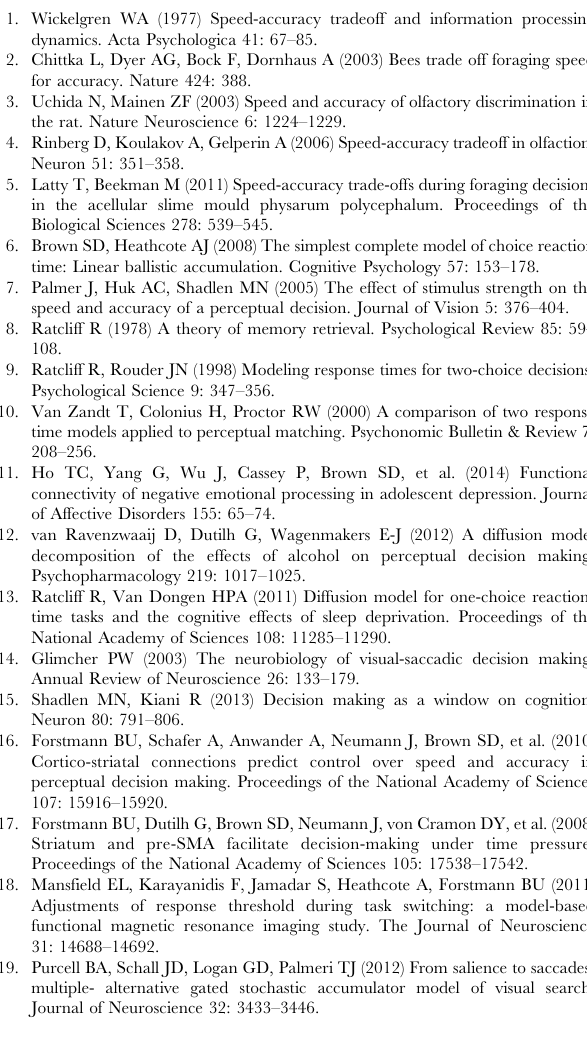
Figure S5 Fine grain structure of response time distributions displyed in Figure 1. Lines overlaid on the accuracy RT distributions represent Gaussian curves. (TIF) Text S1 Details of the sampling method via Markov Chain Monte Carlo integration with proposals generated via differential evolution. (PDF) Text S2 Details of over-constrained version of the model variant in the main